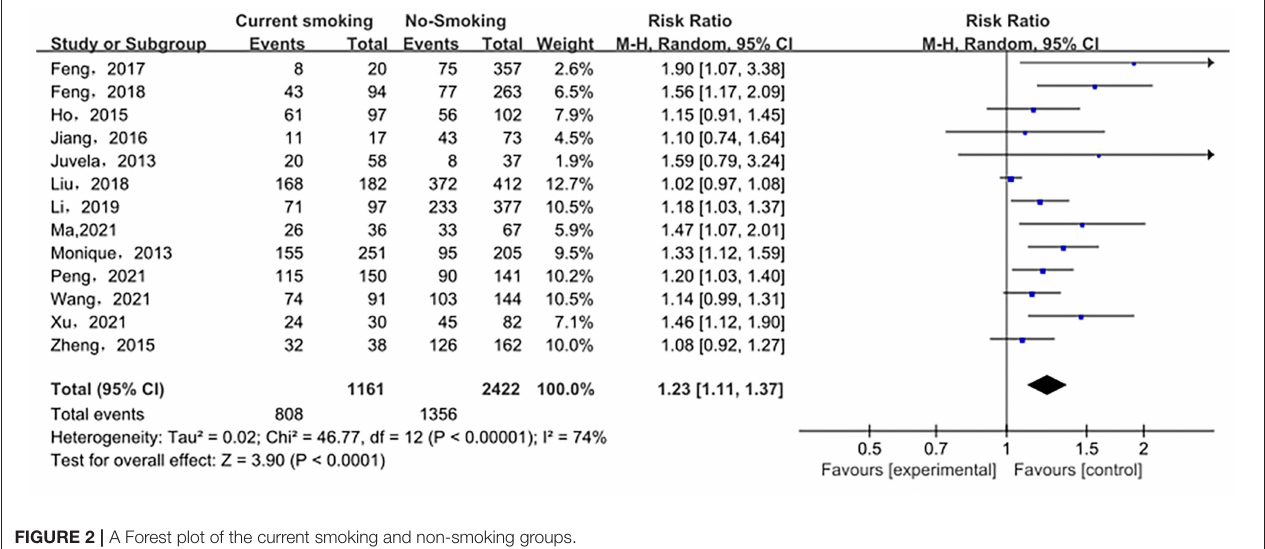
FIGURE 2 | A Forest plot of the current smoking and non-smoking groups.